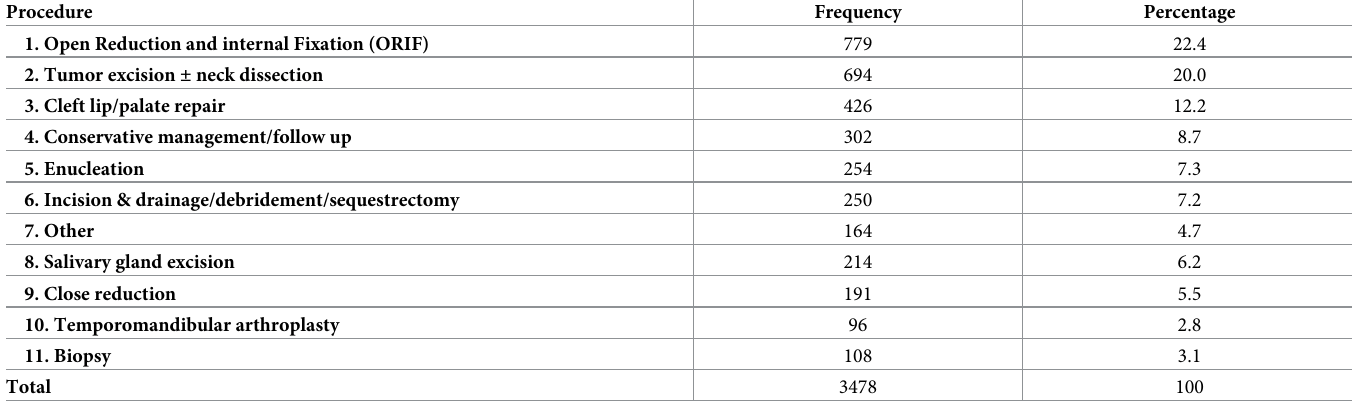
Table 11. Type of